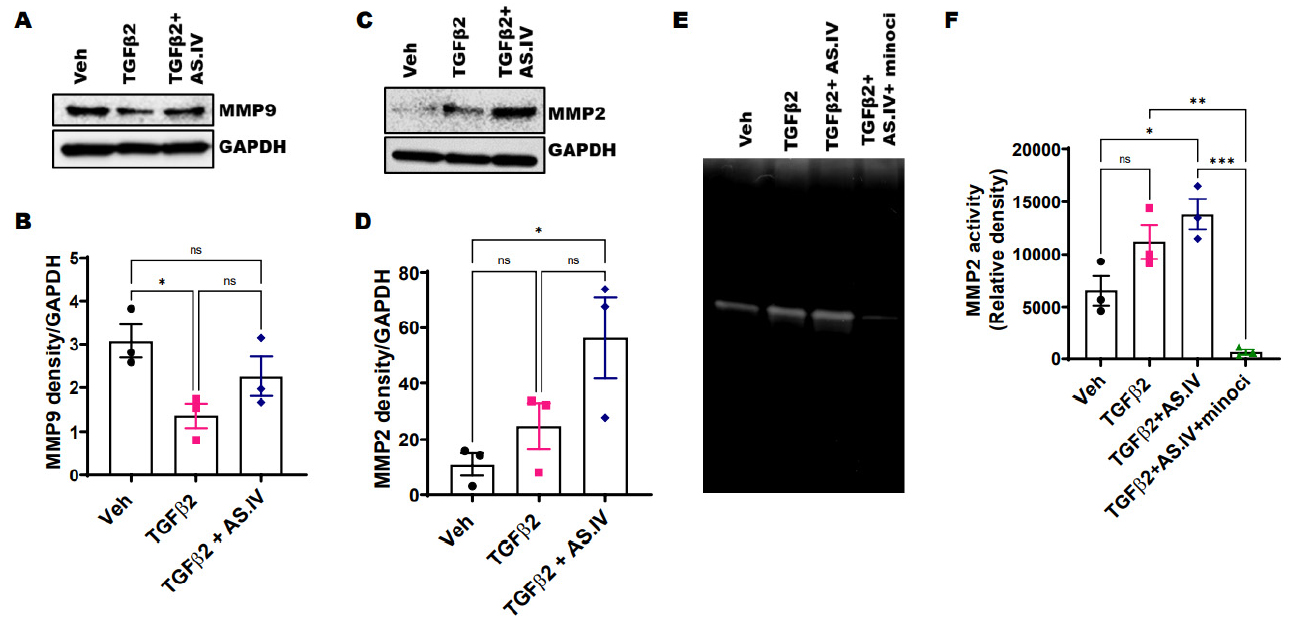
Figure 4. AS.IV treatment enhances the MMPs activity in the TM cells. ( A – D ) The primary human TM cells were treated with vehicle, TGF β 2 (5 ng/mL) and TGF β 2 plus AS.IV (100 µM) for 3 days and the cell lysates were subjected to Western blot ( A , C ) and its densitometric ( B , D ) analysis of MMP9 and MMP2 ( n = 3 cell strains, data represented as mean ± SEM, One-way ANOVA, Tukey’s multiple comparisons test, * p < 0.05). TGF β 2 treatment resulted in a significant reduction of MMP9 levels and a slight increase in MMP2 levels. AS.IV co-treatment prominently increased both MMP9 and MMP2 levels. ( E , F ) The primary human TM cells were treated with vehicle, TGF β 2 (5 ng/mL), TGF β 2 plus AS.IV (100 µM) and TGF β 2 + AS.IV (100 µM) + minocycline (200 µM) for 3 days in a serum free medium and spent medium was concentrated and subjected to the gelatin zymography ( E ). The densitometric analysis ( F ) of the gelatinolytic bands corresponding to MMP2 activity revealed that AS.IV treatment significantly increased the MMP2 activity and this was completely inhibited by minocycline (minoci) treatment, a PAN MMPs inhibitor ( n = 3 cell strains, data represented as mean ± SEM, One-way ANOVA, Tukey’s multiple comparisons test, * p < 0.05, ** p < 0.01, *** p < 0.001, ns - not significant).